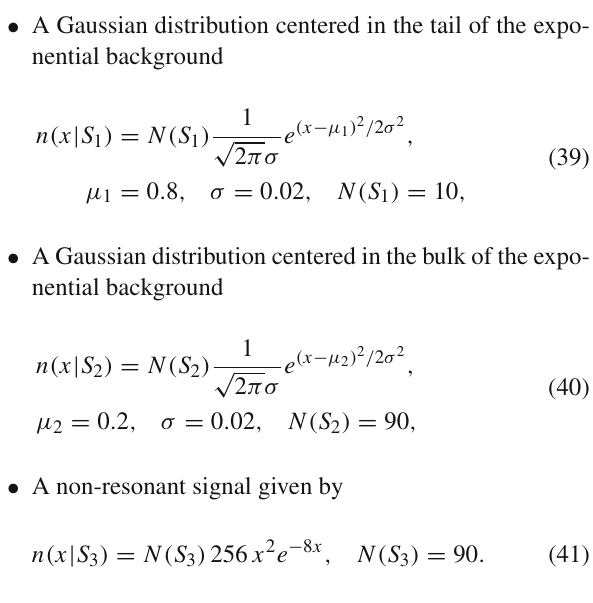
Fig. 9 Euclidean pairwise distance Fig. 11 Average loss and test statistics as functions of the number of conjugate gradient iterations (reference toys)